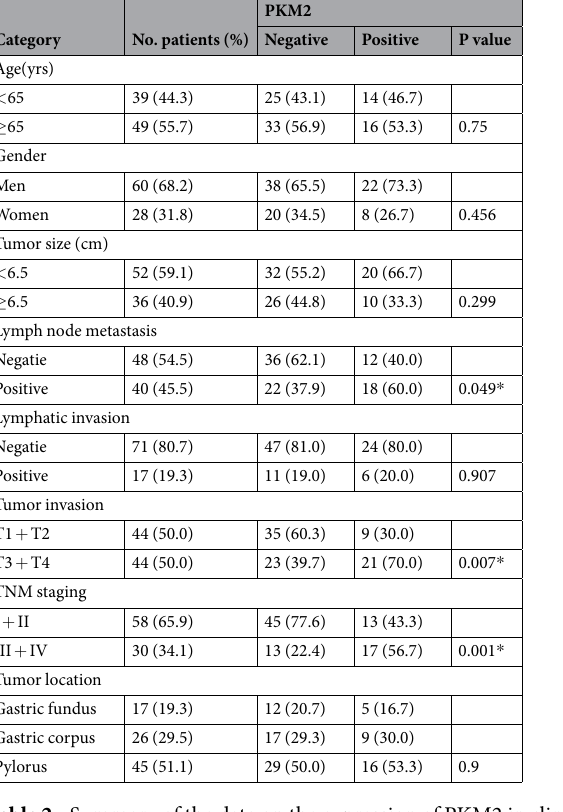
Table 2. Summary of the data on the expression of PKM2 in clinicopathological features of 88 cases of gastric cancer. * The difference is significant in the chi-square test or Fisher’s exact